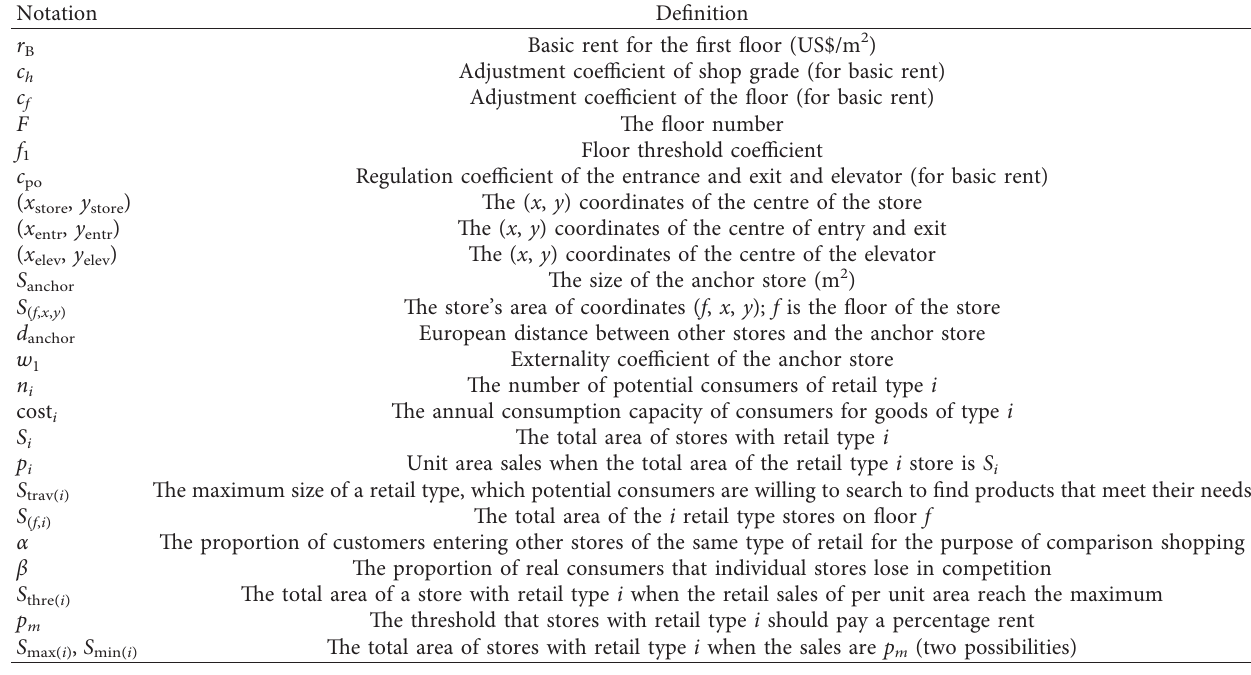
Table 1: Parameters used in the